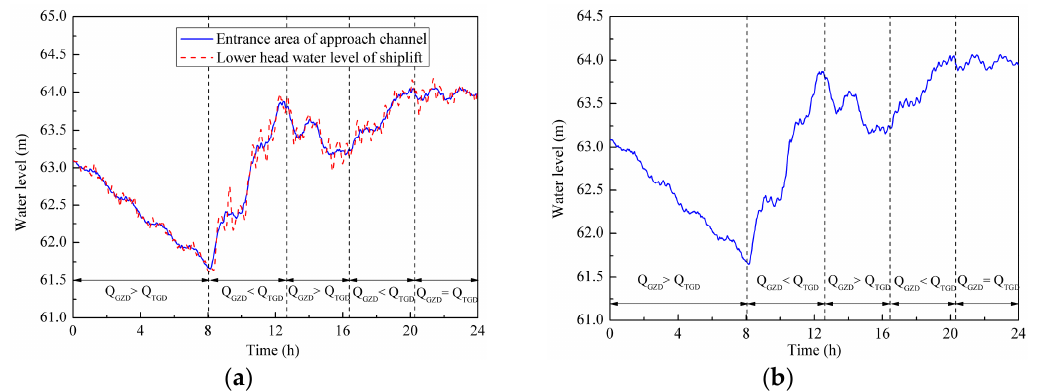
Figure 17. Water level variation process regarding double-peak regulation. ( a ) Approach channel